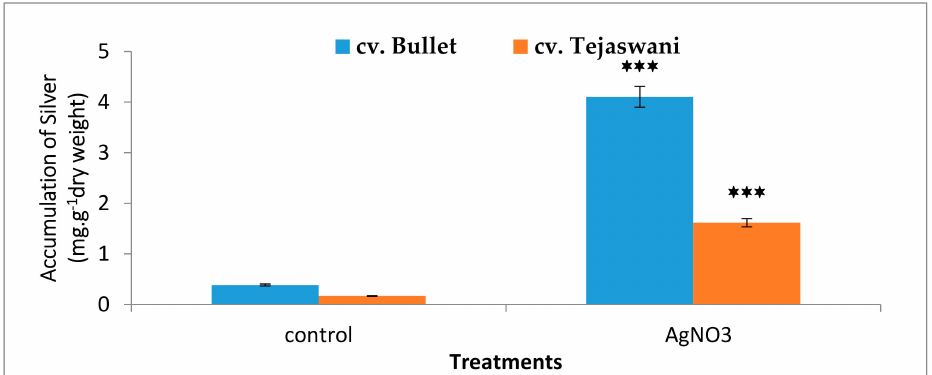
Figure 7. Changes in accumulation of silver of two chilitypes, cv. Bullet and cv . Tejaswani, under treatments (control and AgNO 3 ) after 7 days. The vertical bars represent the data with the mean of three replicates with ± SE ( n = 3) from an individual set of experiments, and significant di ff erences between the treatments as calculated by a student’s t-test marked as * ( p ≤ 0.05) ** ( p ≤ 0.01) *** ( p ≤